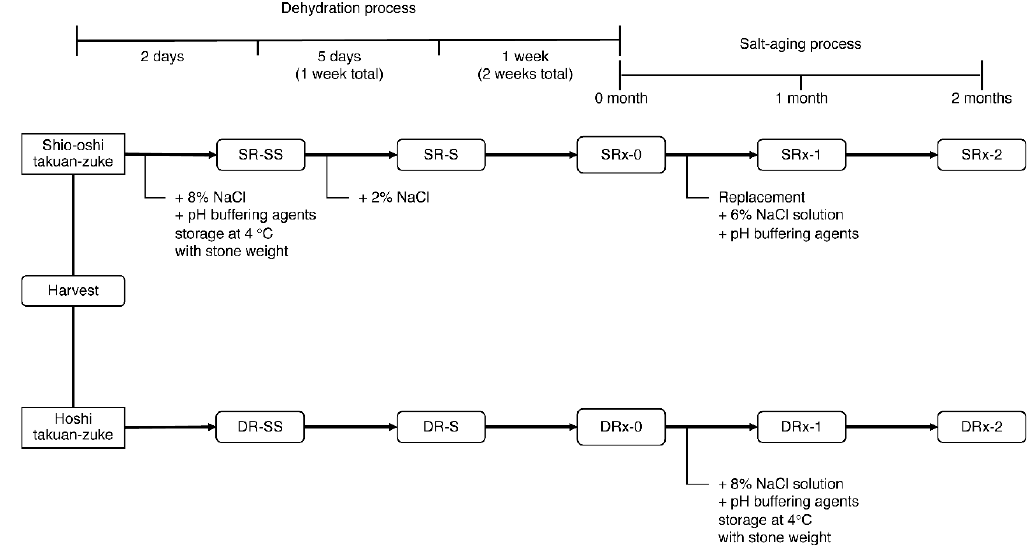
Figure 2. Time schedule for the pickling of daikon. SR indicates dehydration by salting (shio-oshi takuan-zuke). DR indicates dehydration by air-drying (hoshi takuan-zuke); SS indicates two days of dehydration; S indicates one week of dehydration. "X" is the buffer concentration, 0 mmol / kg (only NaCl addition) (SR0 / DR0), 10 mmol / kg addition (SR10 / DR10), 20 mmol / kg addition (SR20 / DR20), and 40 mmol / kg addition (SR40 /